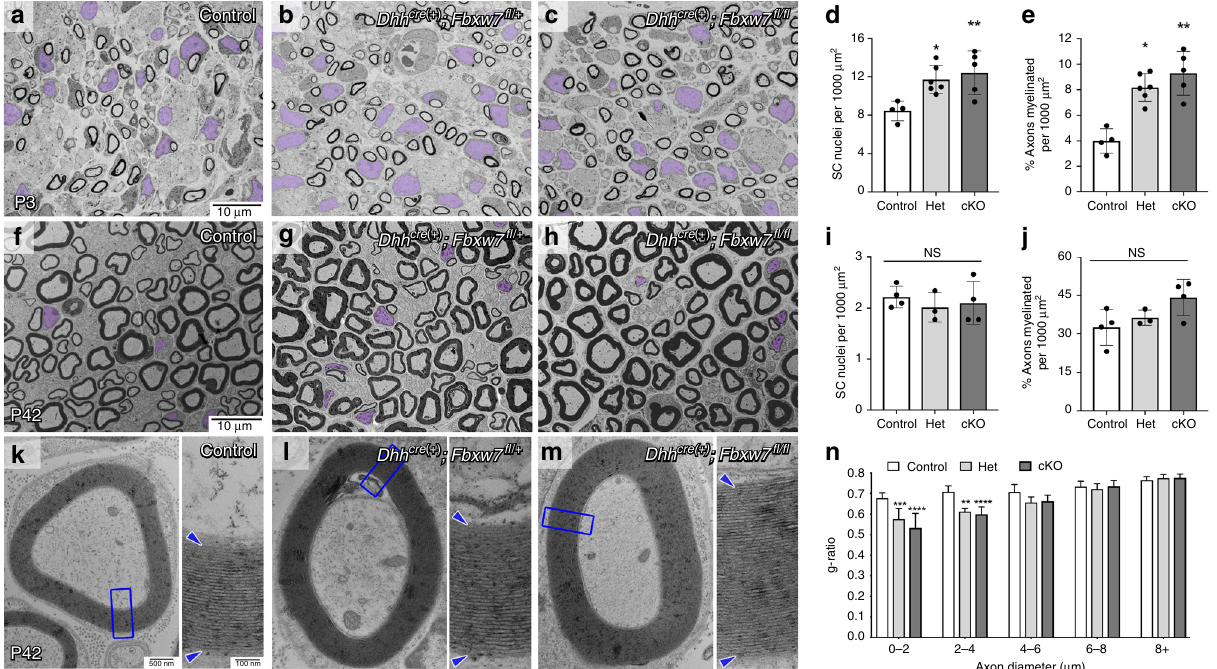
Fig. 1 Fbxw7 is a cell autonomous regulator of SC number and myelin thickness. a – j Transmission electron micrographs (TEMs) and quanti fi cation of SC- speci fi c Fbxw7 mutant mice at P3 ( a – e ) and P42 ( f – j ). At P3, loss of Fbxw7 leads to increased SC number ( d ; nuclei pseudocolored in purple in micrographs; p = 0.0224(*), p = 0.0015(**); one-way ANOVA) and percentage of myelinated axons ( e ; p = 0.0421(*), p = 0.0091(**), one-way ANOVA) in both Dhh cre ( + ) ;Fbxw7 fl / + (Het [heterozygous]) and Dhh cre ( + ) ;Fbxw7 fl / fl (cKO [conditional knockout]) nerves compared with littermate controls. However, by P42, both of these phenotypes have been resolved ( i — Control to Het p = 0.7085, Control to cKO p = 0.8578, Het to cKO p = 0.9470; j — Control to Het p = 0.9583, Control to cKO p = 0.8507, Het to cKO p = 0.9719; one-way ANOVA for i and j ). Mutant SCs also make thicker myelin as evidenced by decreased g-ratios ( k – n ), especially on small diameter axons ( n ; 0 – 2 μ m — p = 0.0010(***), p < 0.0001(****); 2 – 4 μ m — p = 0.0022(**), p < 0.0001(****); two-way ANOVA). Insets are zoomed images of the area indicated by blue boxes. Asterisks above bars indicate comparisons with controls. Comparisons between Dhh cre ( + ) ; Fbxw7 fl / + and Dhh cre ( + ) ;Fbxw7 fl / fl were not signi fi cant ( p > 0.05). P3: N = 4 control, 6 Dhh cre ( + ) ;Fbxw7 fl / + , 5 Dhh cre ( + ) ;Fbxw7 fl / fl . P42: N = 4 control, 3 Dhh cre ( + ) ;Fbxw7 fl / + , 4 Dhh cre ( + ) ;Fbxw7 fl / fl . Error bars depict